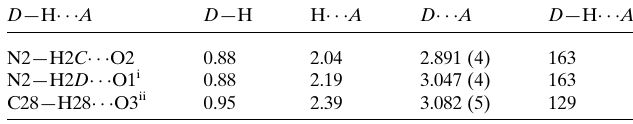
Table 2 Hydrogen-bond geometry (A˚ , (cid:4) ).